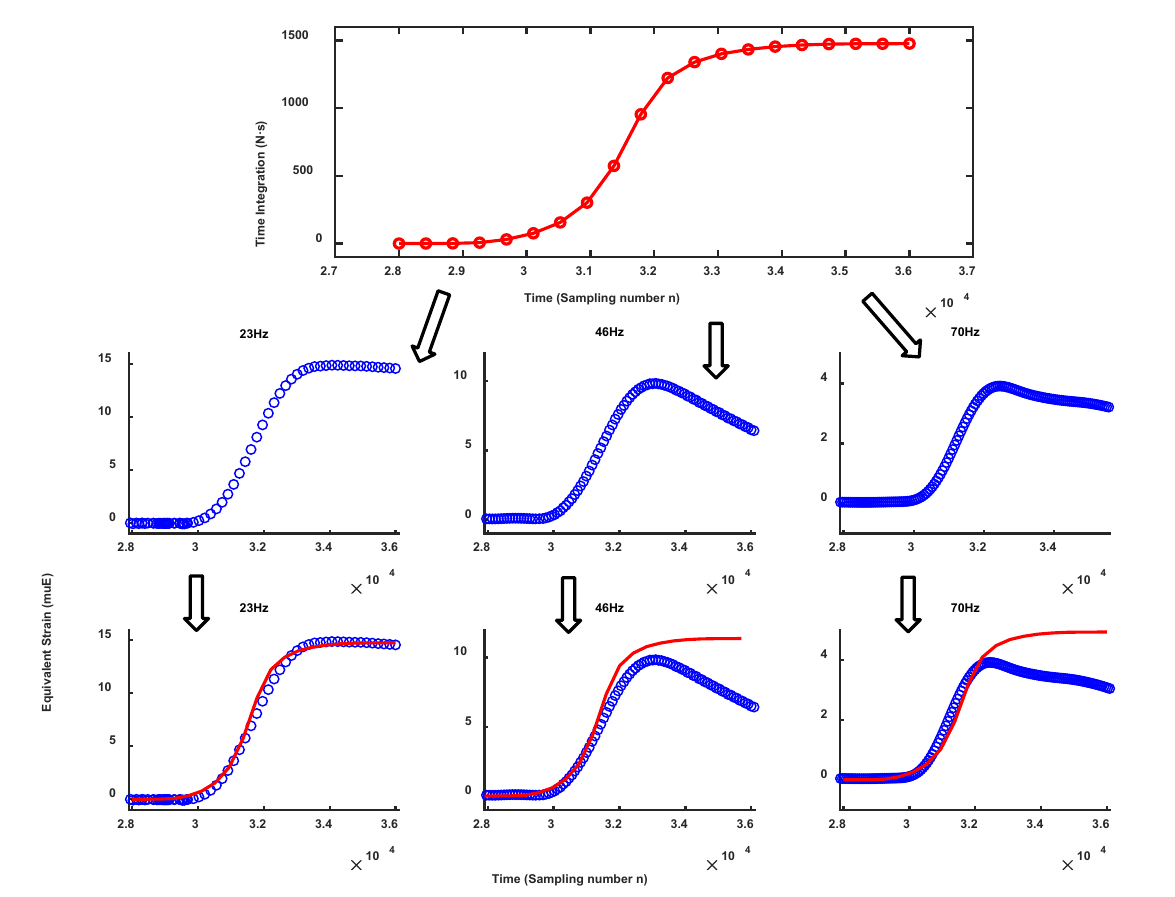
Figure 12. Schematic diagram of linear relation of load–time discrete integration and the peak value (amplitude of sine wave) of the oscillation period.